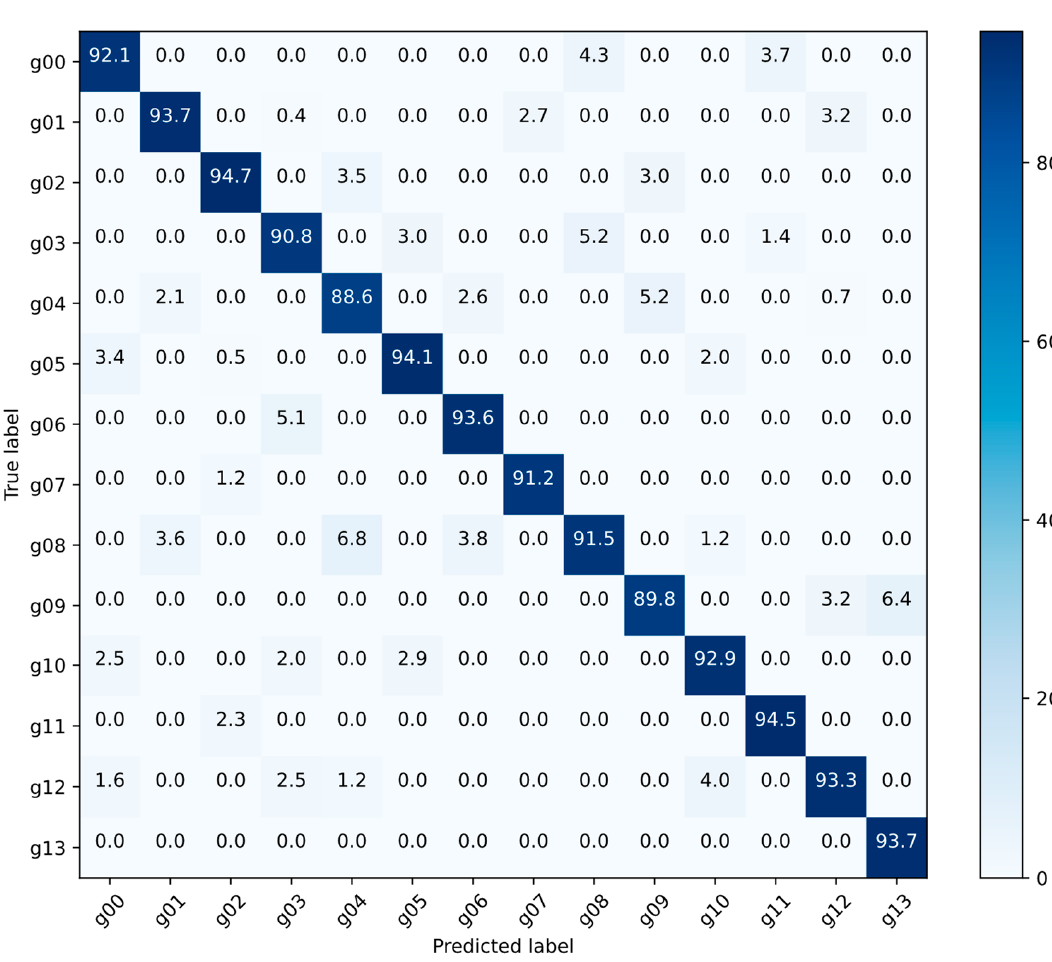
Figure 6. Confusion matrix of results on the NVGesture dataset. Table 3. Comparison of the proposed method on the NVGesture dataset.